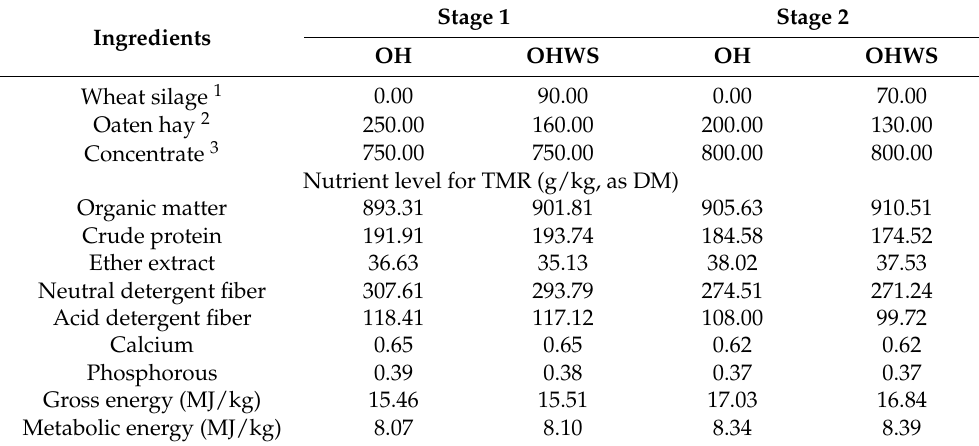
Table 1. Ingredient and chemical composition of experimental diets for